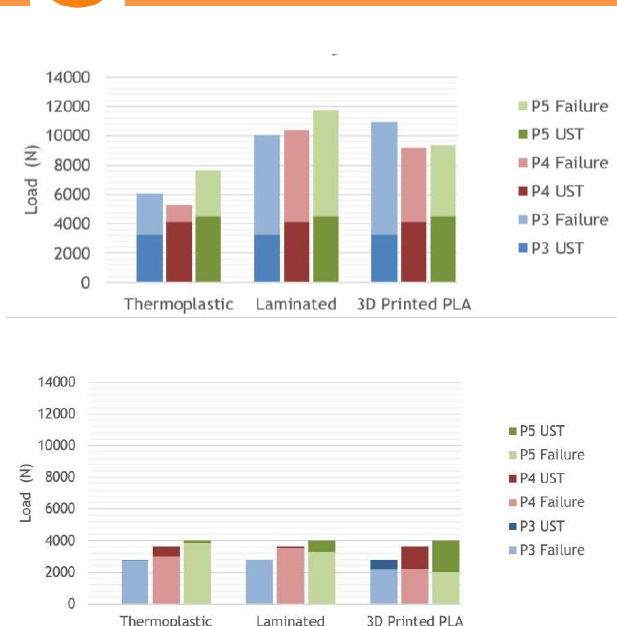
FIGURE 6 . A (TOP): For locking sockets at Condition I (early stance phase), all of the set ups failed above the ultimate strength test values specified in ISO 10328; B (Bottom): For locking sockets at Condition II (late stance phase), all the set ups failed below the ultimate strength test values specified in ISO 10328.